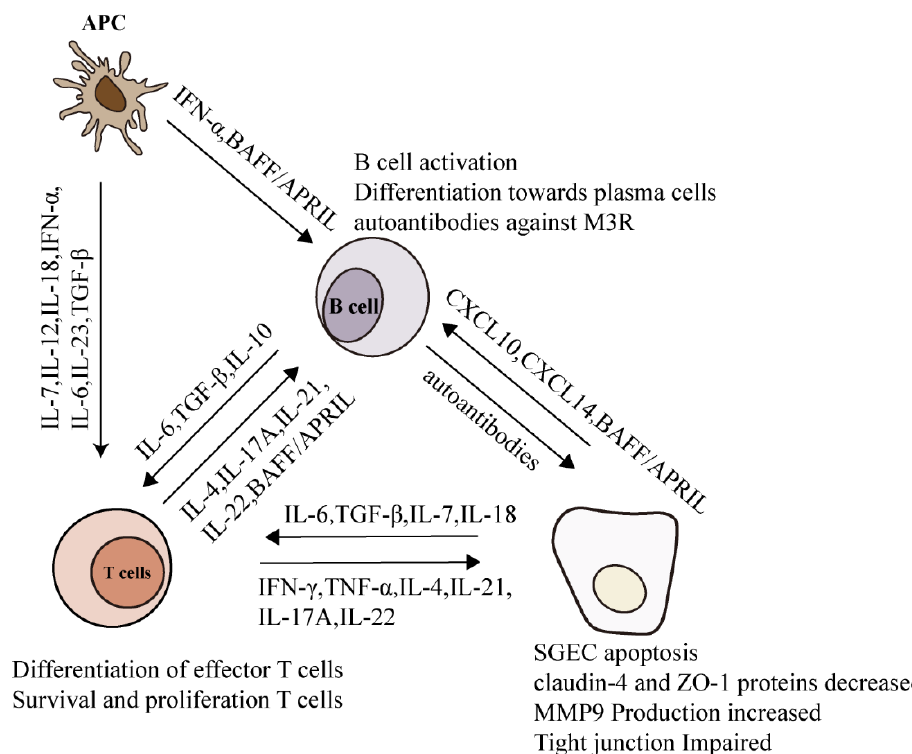
Figure 3. Mutual interactions between T cells, B cells and SGECs result in the immunopathogenesis of SjS. Infiltrated T and B cells in the SGs of SjS patients produce pro-inflammatory cytokines, such as IFNs and interleukins, acting on them mutually to further aggravate the autoimmune response. In addition, these pro-inflammatory cytokines also act on SGECs, inducing the destructions of glandular tissues.